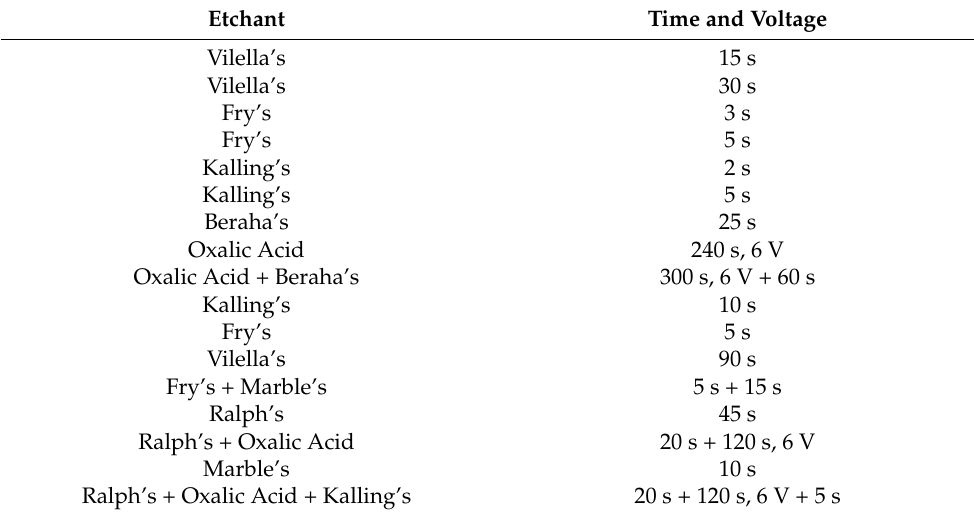
Table 4. Investigated combinations of etching strategies.